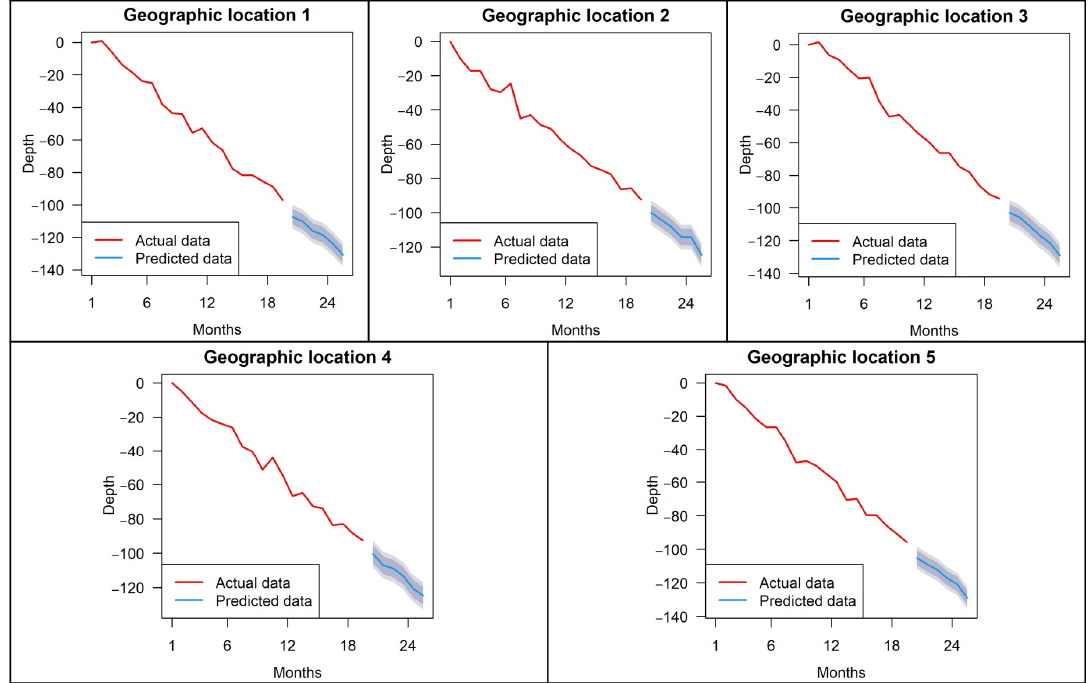
Figure 15. Holt–Winters smoothing model prediction results (Unit: mm).